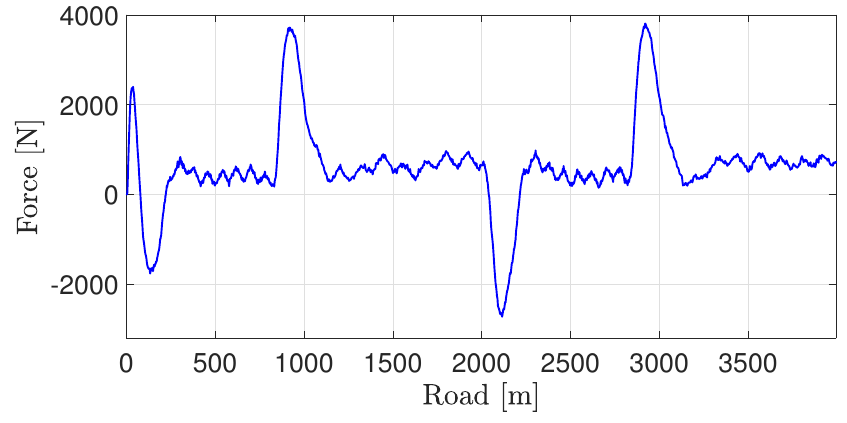
Figure 11. Longitudinal control